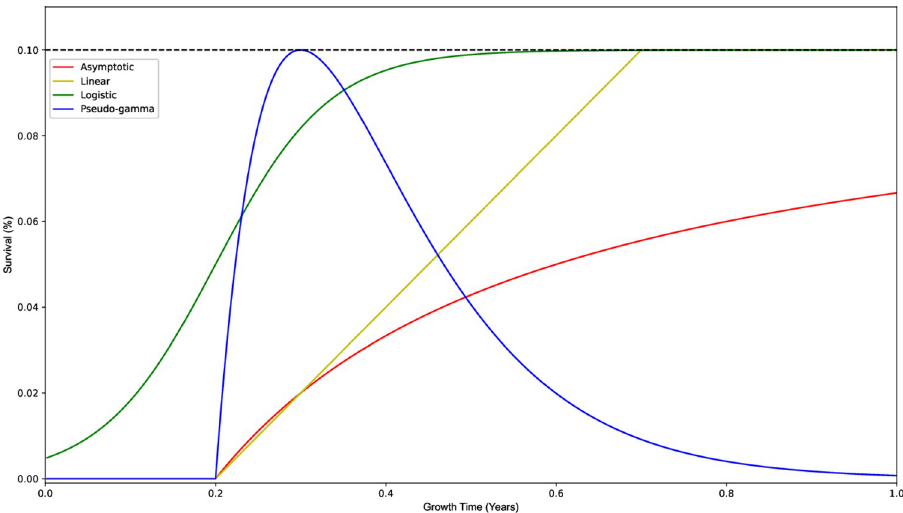
Fig 2. Proportional survival plot of asymptotic, linear, logistic, and pseudo-gamma functional forms against growth time. c = 25, 0.2, 15, 10 respectively. p min = 0, p max = 0.1 (black dashed line), t 0 =